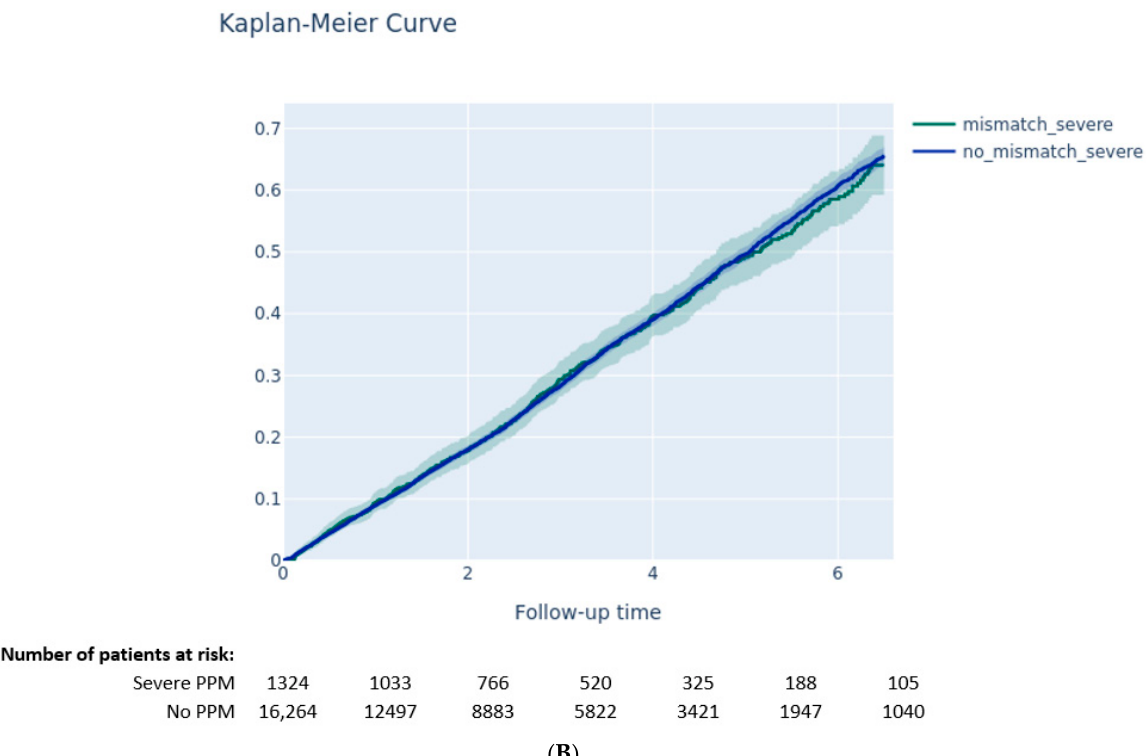
Figure 2. ( A ) Survival according to the presence of moderate-to-severe patient–prosthesis mismatch (Kaplan–Meier curve). ( B ) Survival according to the presence of severe patient–prosthesis mismatch (Kaplan–Meier curve).